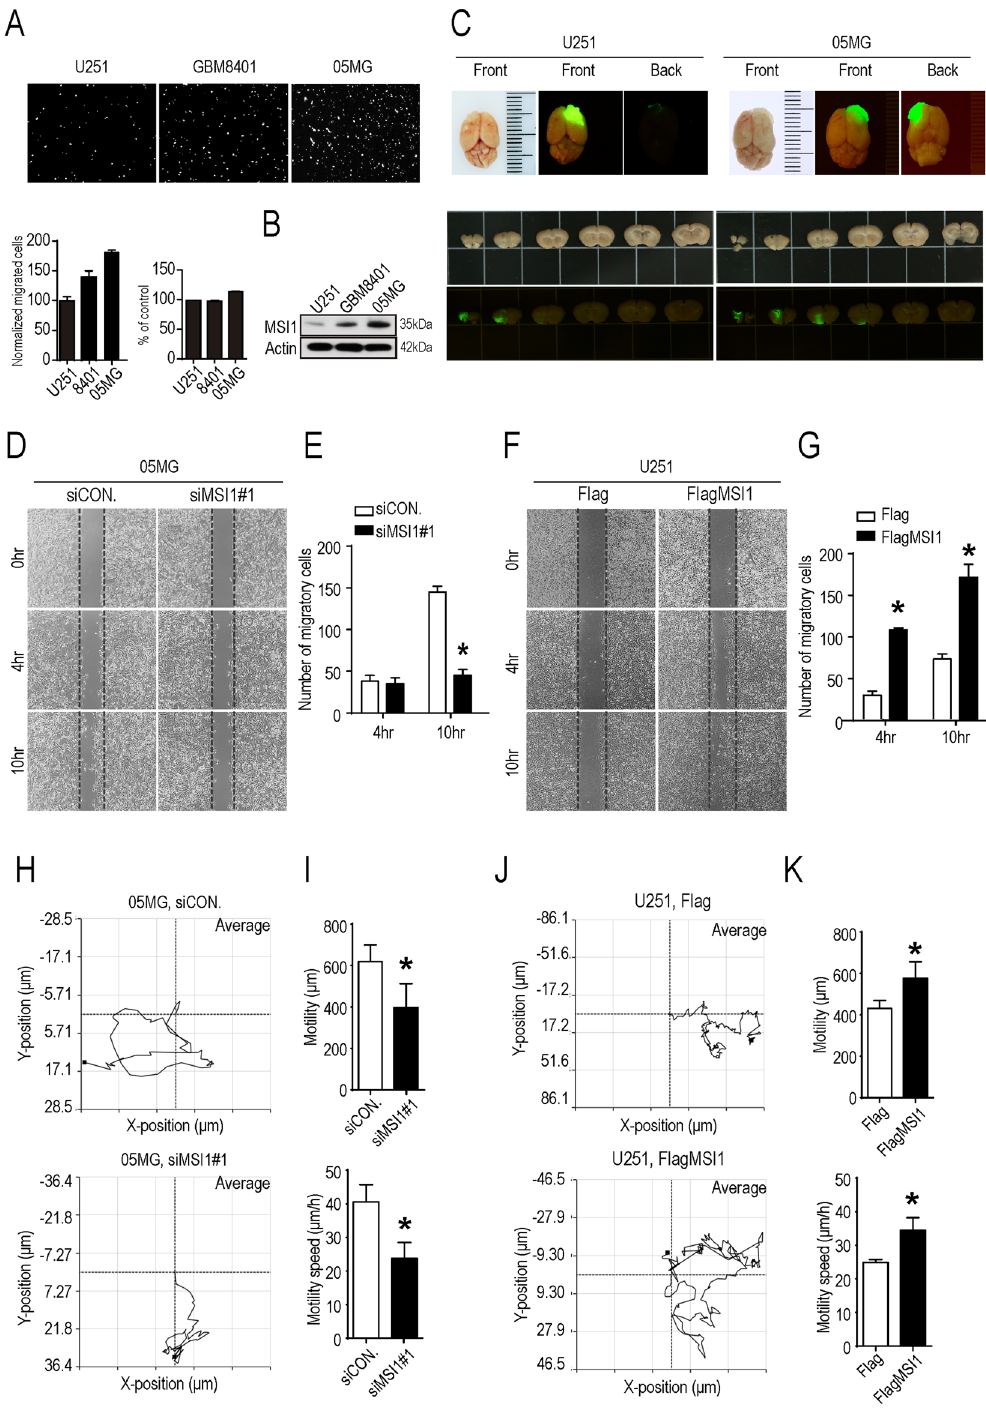
Figure 1. MSI1 promoted GBM cells migration. ( A ) U251, GBM8401, and 05MG GBM cell lines were subjected to a 24-hour Transwell migration assay. Cells were plated in the upper chamber, after 24 hours plating, migrating cells that moved to the underside of the filters were fixed and stained with PI (Propidium iodide). Relative cell migration was determined by the number of the migrated cells normalized to the total number of the cell, and the value from U251 cell was arbitrarily set at 100%; the percentage of cell numbers were indicated by alamar blue assay shown in bar chart. ( B ) Western blot analysis of MSI1 expression in U251, GBM8401 and 05MG cell lines, of which the uncropped blots were demonstrated in Supplementary Figure 5. ( C ) SCID mice were orthotopically transplanted with 1.5 × 10 5 GFP-labeled U251 or 1.5 × 10 5 GFP-labeled 05MG cells. Representative tumor photographs of GFP images were taken 63 days after transplantation. ( D , E ) 05MG cell transiently transfected with siRNA against MSI1 (siMSI1) or scrambled siRNA control (siCON.), and the number of migrated cells at 4 and 10 hours were calculated. ( F , G ) U251 cells were transiently transfected with Flag-tagged MSI1 (FlagMSI1) or Flag control (Flag), and the number of migrated cells at 4 and 10 hours